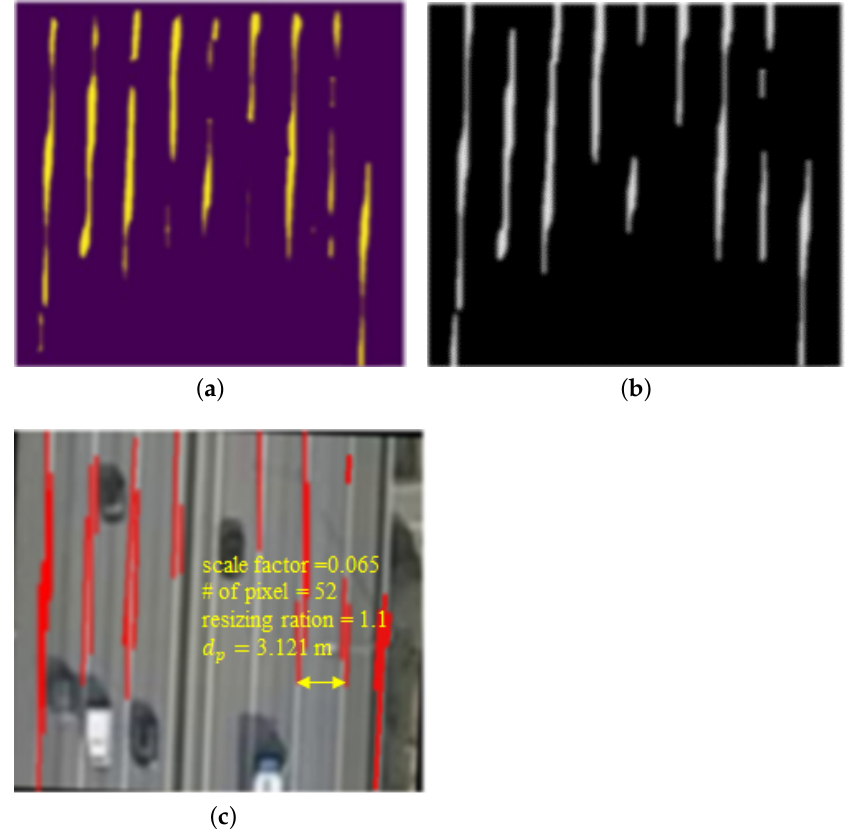
Figure 6. Lane detection process in three steps. ( a ) Lane-Net for pre-processed image; ( b ) image morphology operations; ( c ) detection of straight lines by the Hough